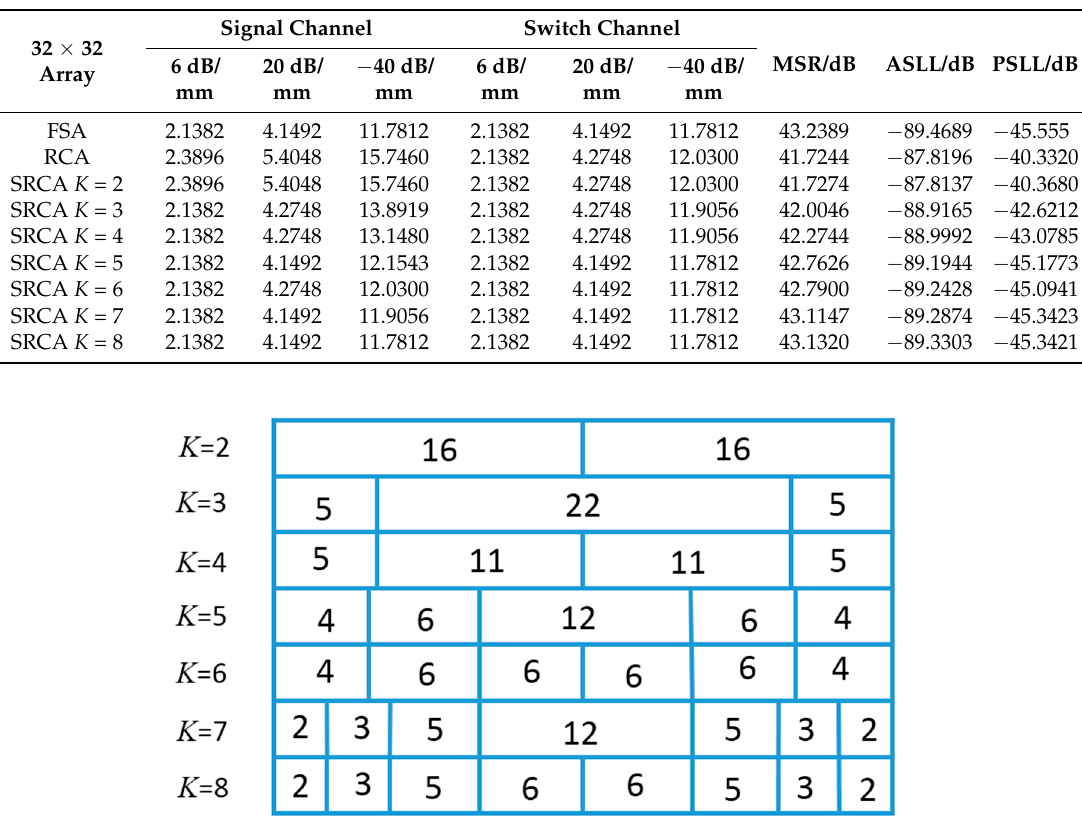
Figure 7. The best split scheme of SRCA with K from 2–8 for 32 × 32 array.